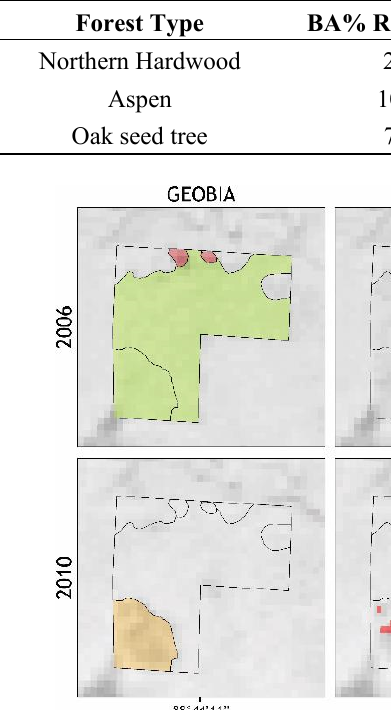
Table 3. Description of the harvest events occurring in the VU.